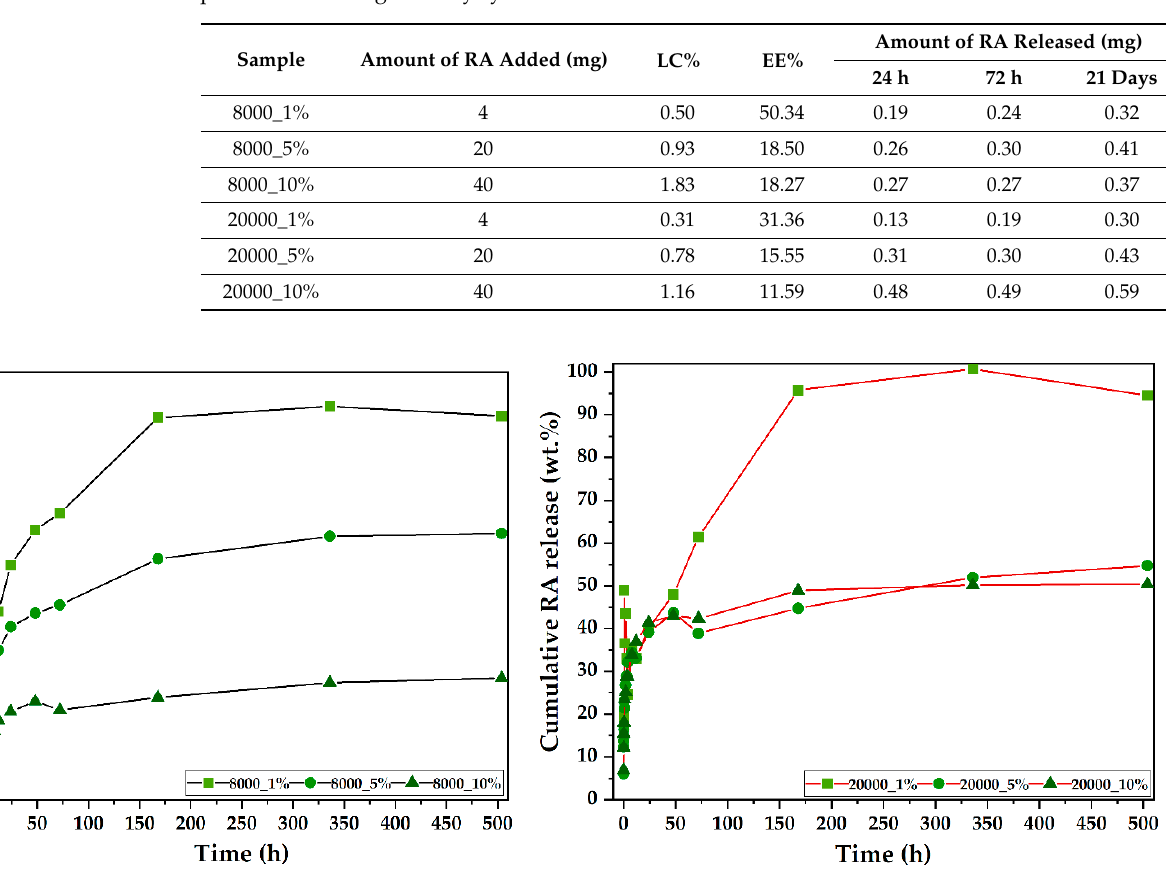
Figure 7. Cumulative release profiles at established time points for the RA-loaded magnetite microspheres (8000— left and 20000— right ).